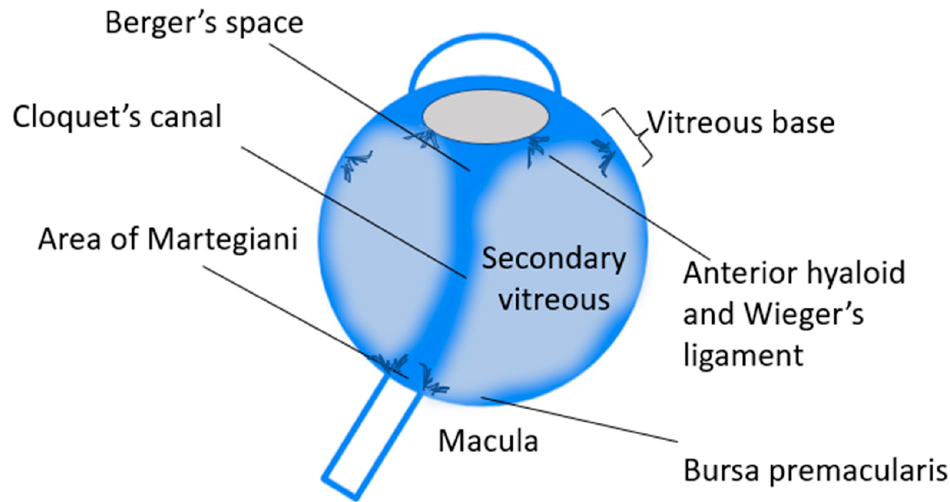
Figure 2. Anatomy of the vitreous body and adjacent structures. In order to adapt to the surround- ing anatomical structures, similarly to water in a complexly shaped container, the vitreous body must bridge and connect the tissues, leaving spaces and adhesion points whose function is often incompletely known and difficult to reproduce by vitreous substitutes. The embryological vitreous also testifies to the final anatomy, and the Cloquet’s canal represents the major remnant due to the regression of the hyaloid artery [17].